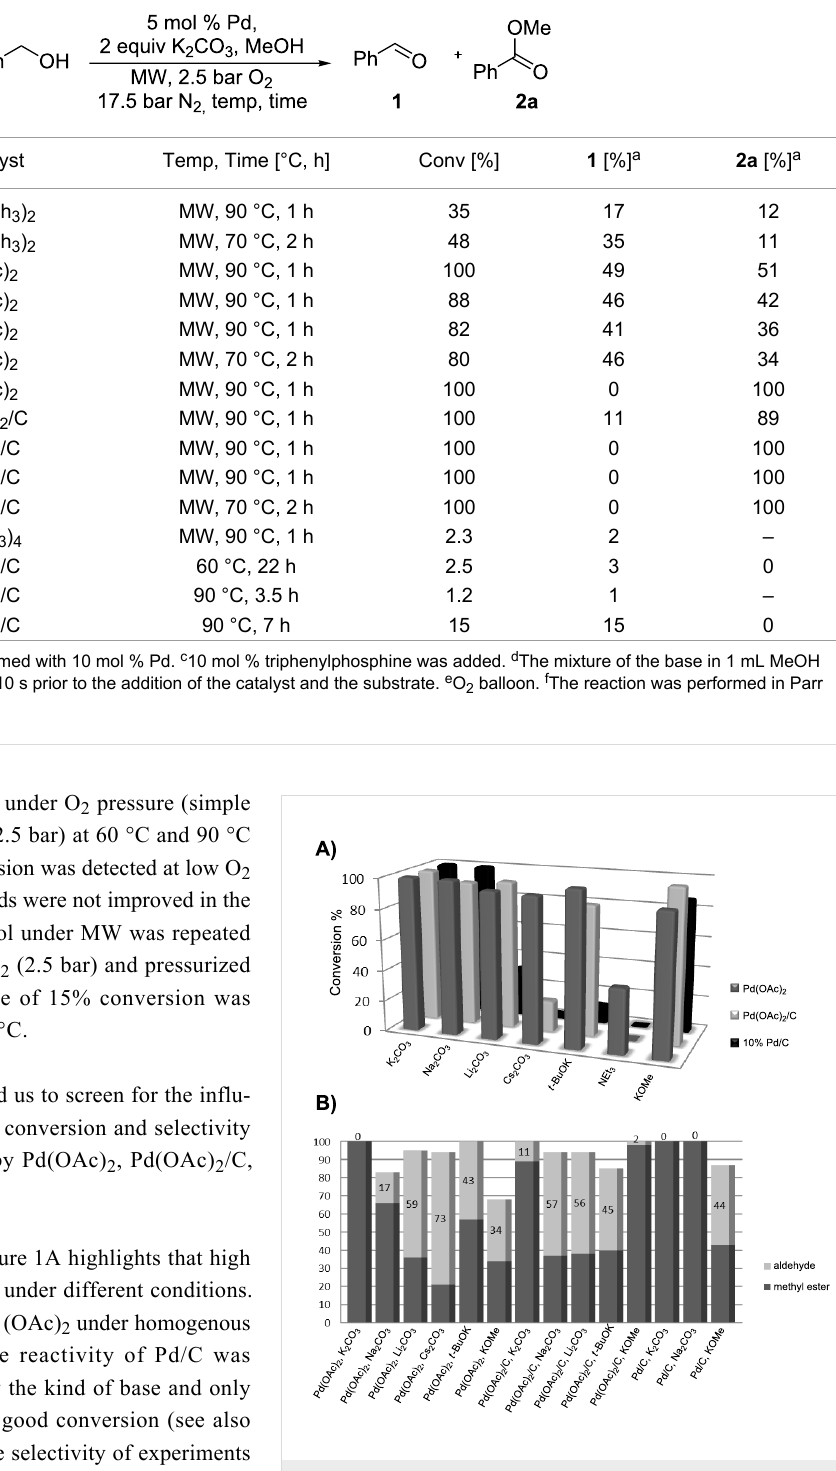
Figure 1: Screening of different catalysts and bases in the catalytic oxidative esterification of benzylalcohol. A) Comparison of the methyl benzoate yield. B) Comparison of the benzylalcohol conversion and selectivity. Conditions: 1 mmol benzylalcohol, 5 mol % Pd, 2